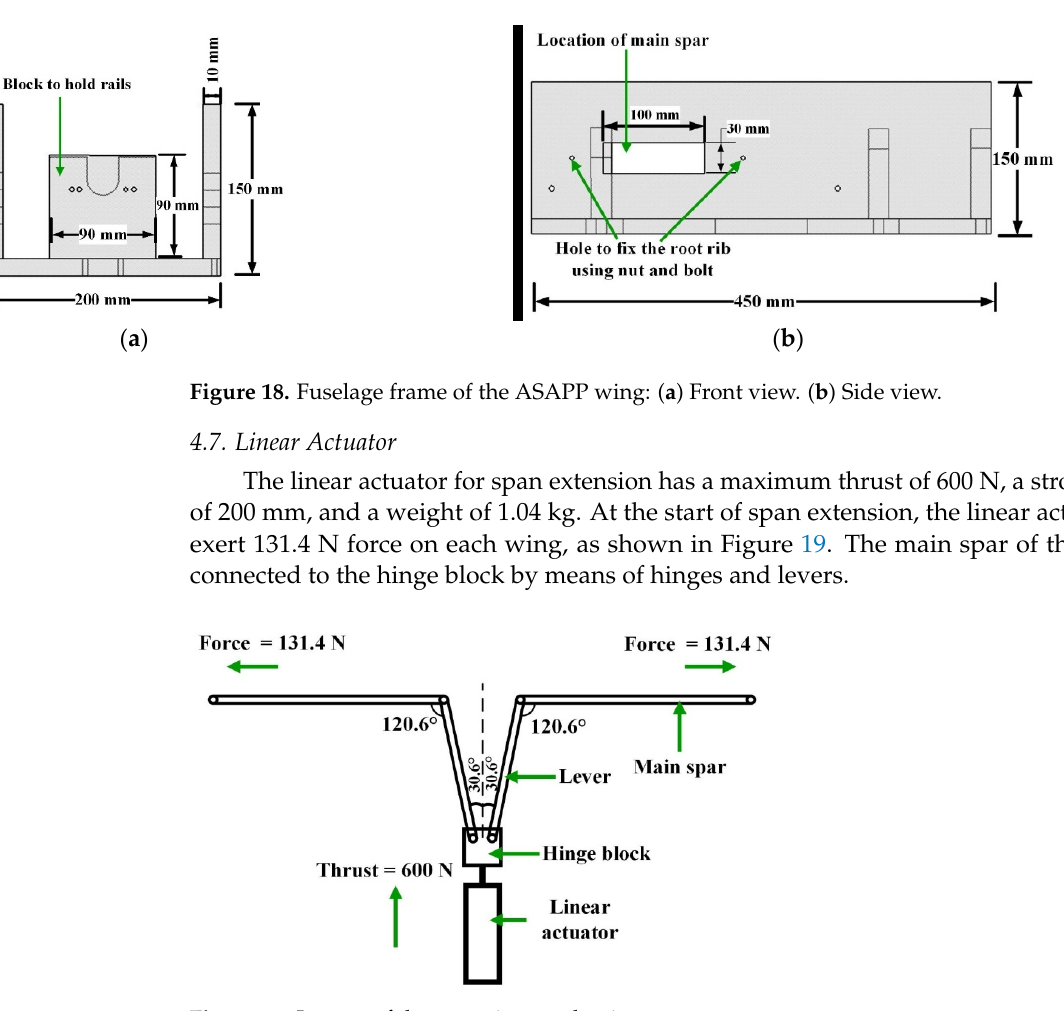
Figure 19. Layout of the actuation mechanism.